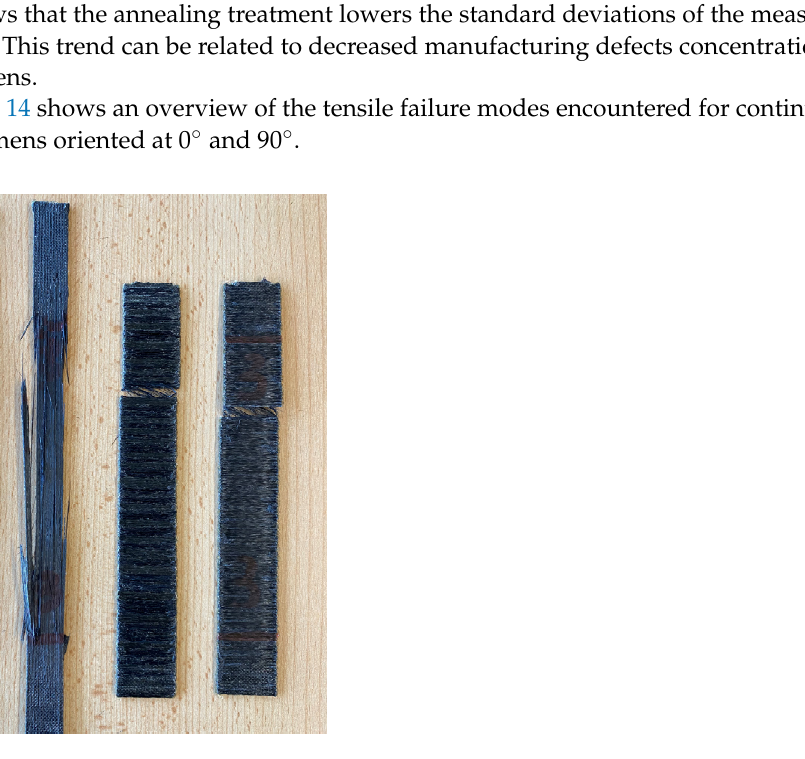
Figure 14. Tensile failure modes of continuous FRP, 0° ( left ); tensile failure modes of continuous FRP, 90° ( right ).